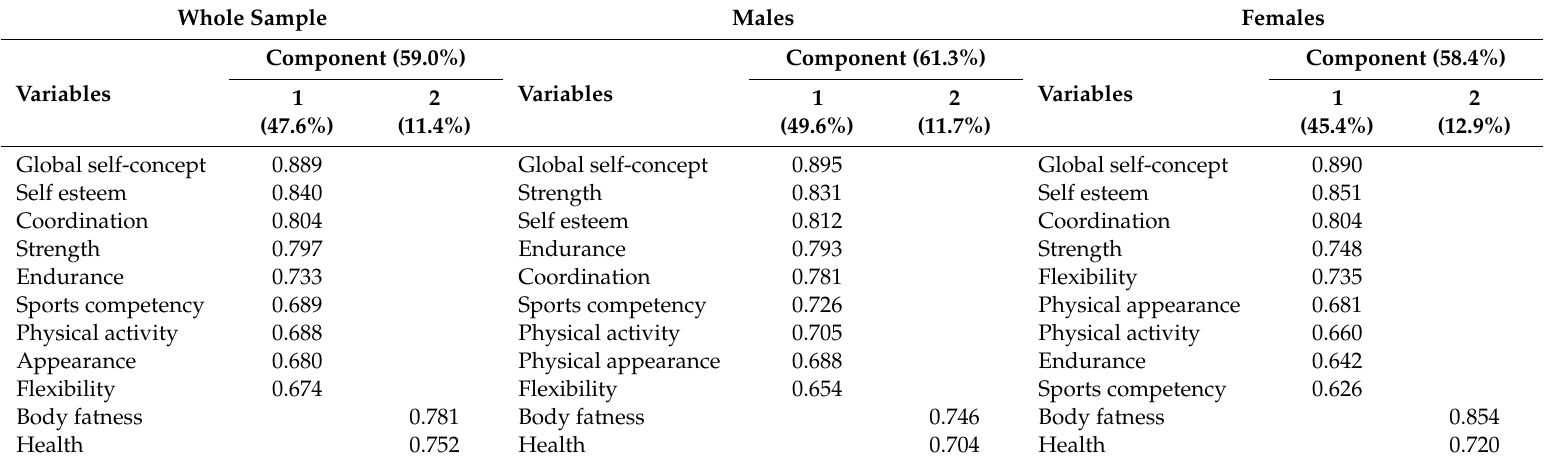
Table 2. Principal component analysis for perceived components of physical fitness.